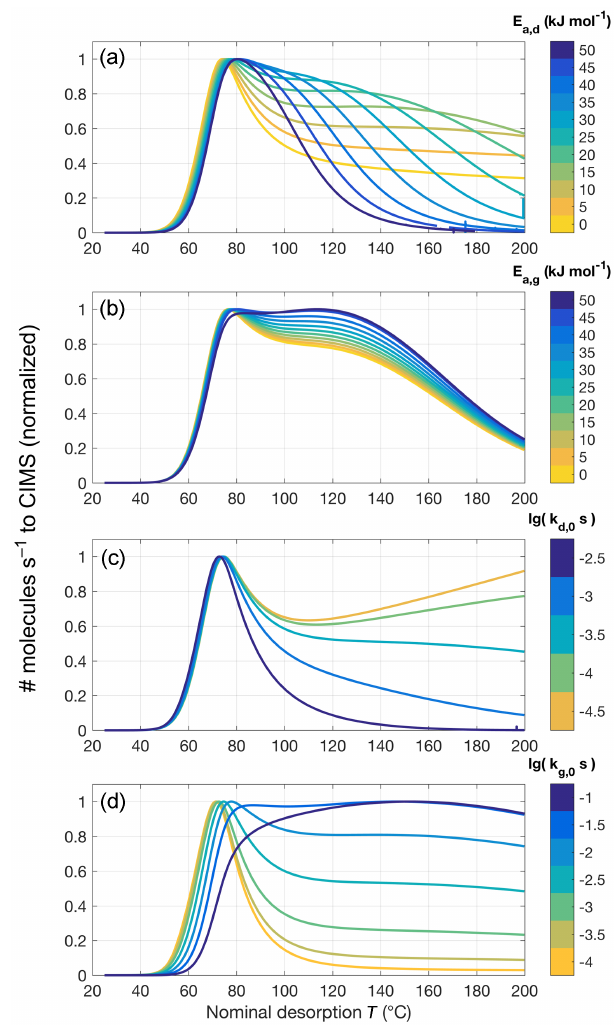
Figure 8. Sample sensitivity tests for the four parameters con- trolling oligomer formation and dissociation. The same model pa- rameters are used as for sensitivity tests shown in Fig. 6 but in- cluding oligomerization (in the forward direction, denoted by sub- script g, and reverse direction, denoted by subscript d). The default values used, unless noted otherwise, are E d = 10kJmol − 1 , E g = 0kJmol − 1 , k g , 0 = 3 × 10 − 4 s − 1 , and k d , 0 = 3 × 10 − 4 s − 1 . For (a) , E d varies between 0 and 50kJmol − 1 , while E g is 25kJmol − 1 , and vice versa for (b) ( E d = 25kJmol − 1 , E g = 0 to 50kJmol − 1 ). (c) and (d) show variations in k d , 0 from 3 × 10 − 5 to 3 × 10 − 3 s − 1 and k g , 0 from 10 − 4 to 10 − 1 s − 1 ,